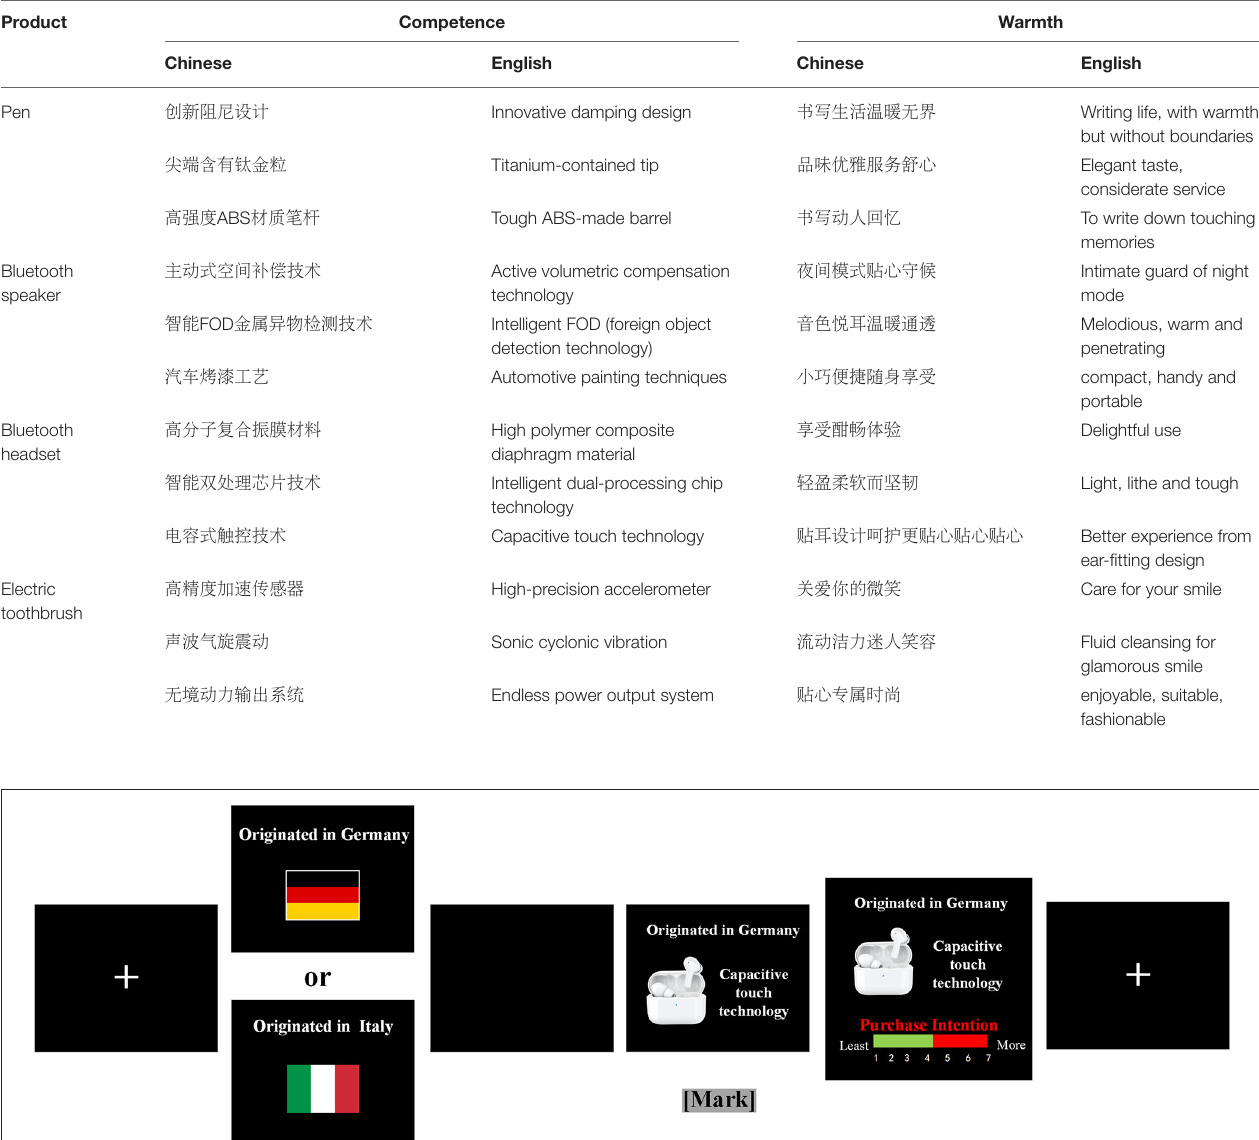
TABLE 1 | Examples of the brand positioning advertising slogans.